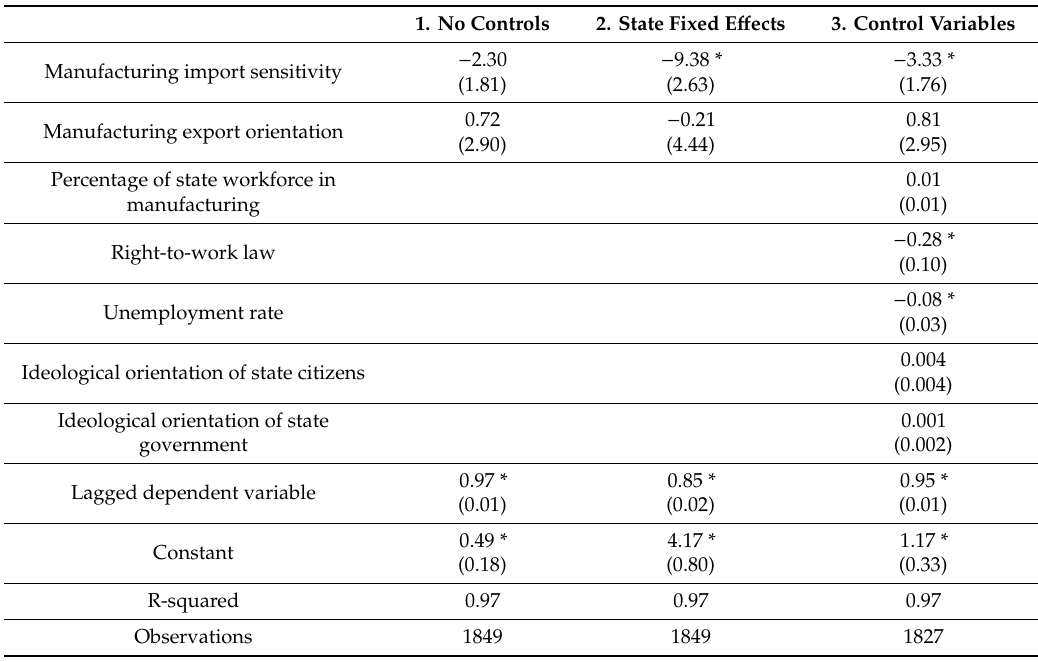
Table 3. OLS Models of Union Density in U.S. States,